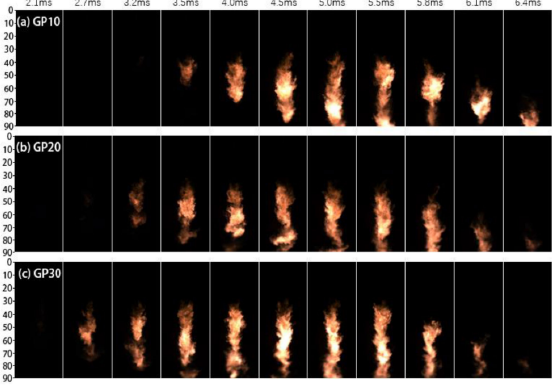
Fig. 18 The combustion process of gasoline/PODE n blends